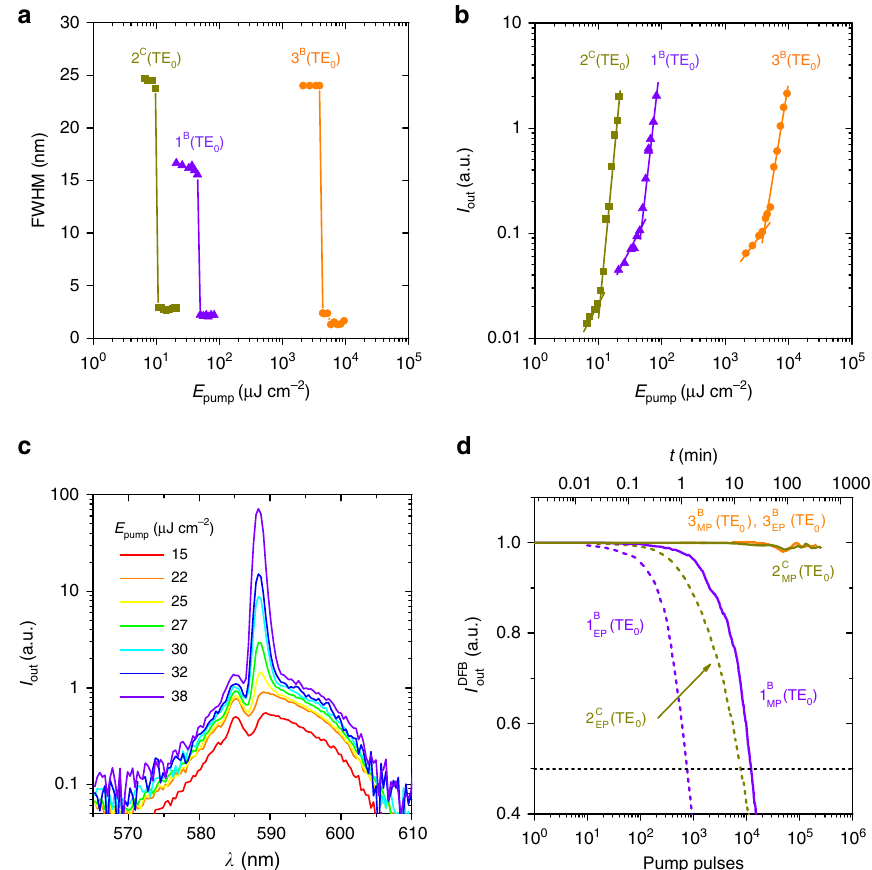
Fig. 3 Threshold and operational lifetime performance of nanographene lasers. a Emission linewidth, de fi ned as the full width at half maximum (FWHM), as a function of the pump energy density, E pump , for the laser peaks associated with the TE 0 waveguide modes of devices 1 B , 2 C , and 3 B . Full lines are guides to the eye. The DFB threshold for each case, E th-DFB , is de fi ned as the E pump at which the FWHM decays to half of its maximum value ( E th-DFB values in Table 2). b Log – Log plots of output intensity, I out , as a function of the pump energy density, E pump , for the same laser peaks shown in panel a ). For each case, I out is collected at the corresponding λ DFB . Full lines are guides to the eye. c Evolution of the laser spectrum with E pump for device 2 B . d DFB intensity, I out DFB , versus time, t , and versus the number of pump pulses (top and bottom axes, respectively) for the same laser peaks shown in panel a ) within this fi gure. The operational lifetime ( τ DFB ) for each case is de fi ned as the time (or number of pump pulses), at which I DFB decays to half of its initial value. 1/2 out Excitation was done at the same spot of the device in air under a moderate pump (MP, full lines) of ( E pump / E th-DFB ) ≈ 4, or under an extreme pump (EP, dashed lines) of E pump = 2 × 10 4 μ J cm − 2 . Source data are provided as a Source Data fi le in the Institutional Repository of the University of